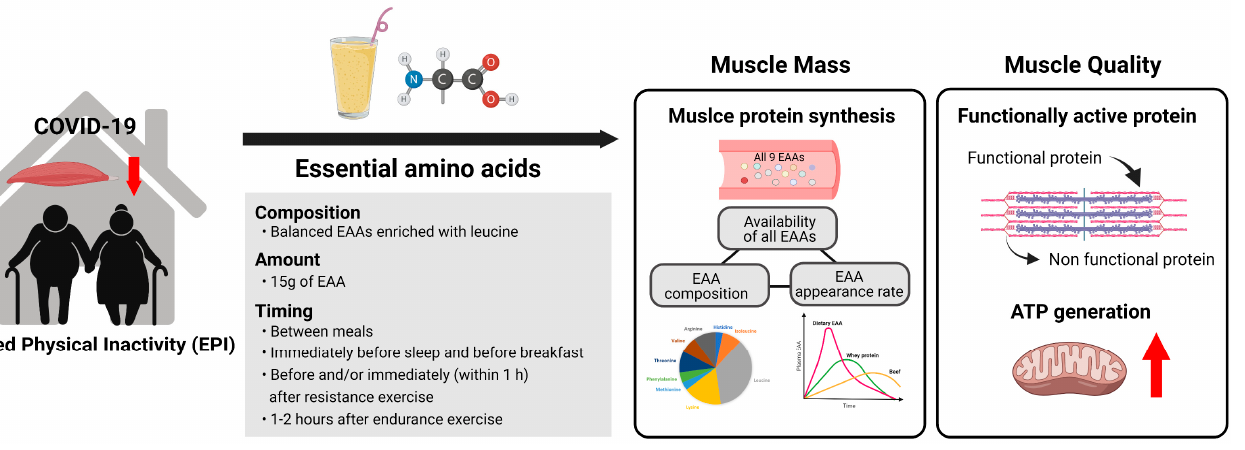
Figure 2. Summary of beneficial impacts of dietary EAAs on aging muscle in EPI. To maximize the benefits of dietary EAAs, three key factors need to be optimized: (1) composition (i.e., balanced EAAs), (2) amount of EAA intake (~15 g EAAs per intake), and (3) timing of EAA intake (e.g., between meals, before and/or post-exercise). Optimal EAA intake leads to greater stimulation of muscle protein synthesis (MPS) through increased availability of plasma EAAs and, in turn, gains in muscle mass and function as well as muscle quality (force production for a given muscle mass). Improvement of muscle quality is likely driven by enhancements in muscle protein turnover (i.e.,